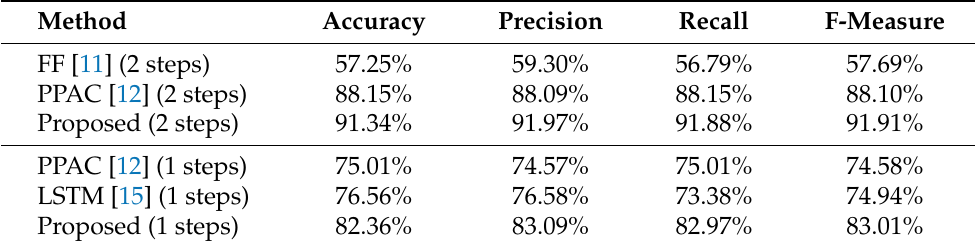
Table 5. Performance comparison of pedestrian